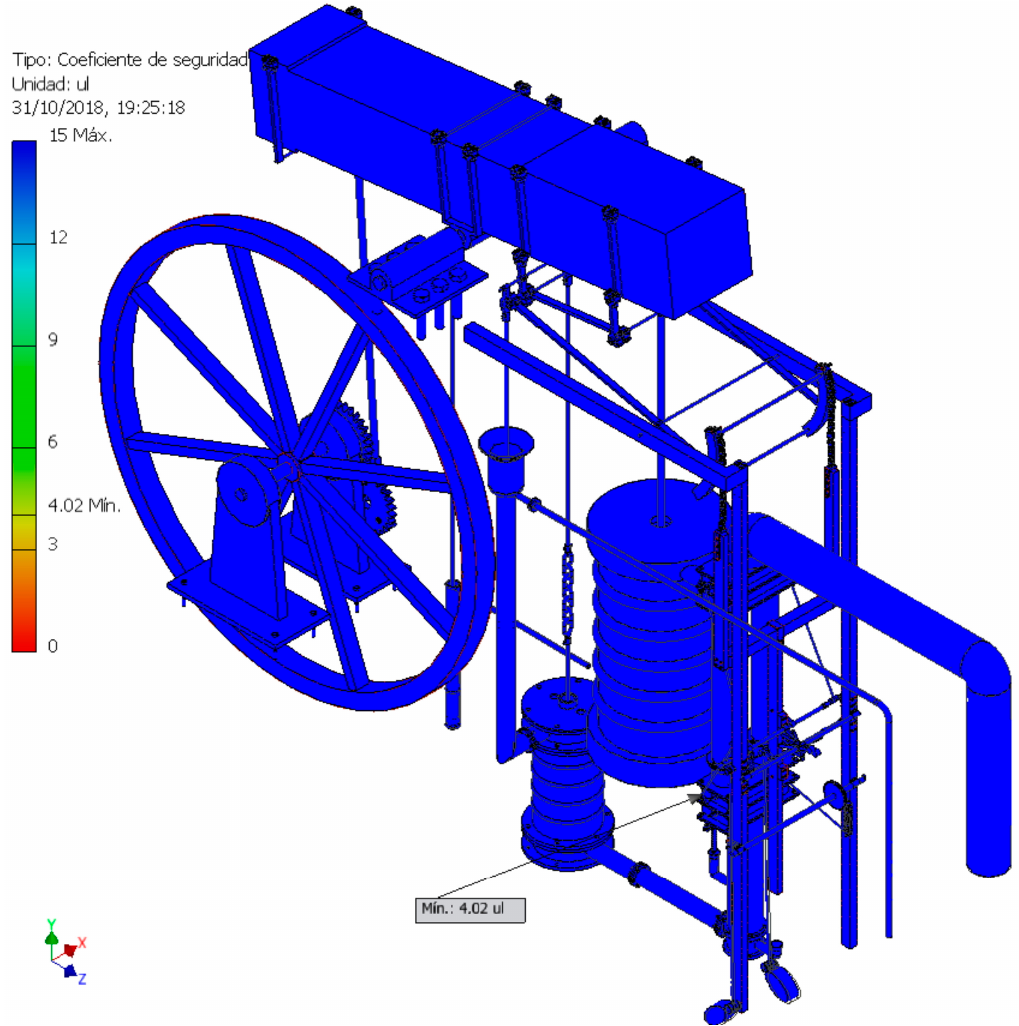
Figure 17. Distribution of safety coefficients.